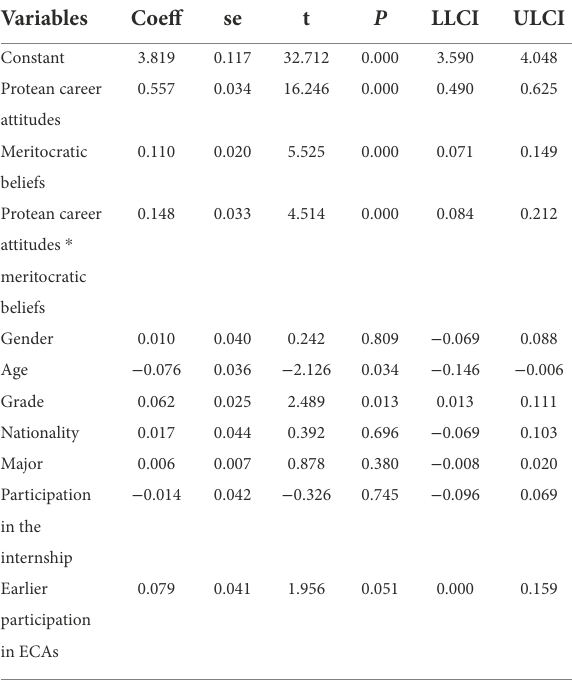
TABLE 4 Bootstrapping test results of the moderation